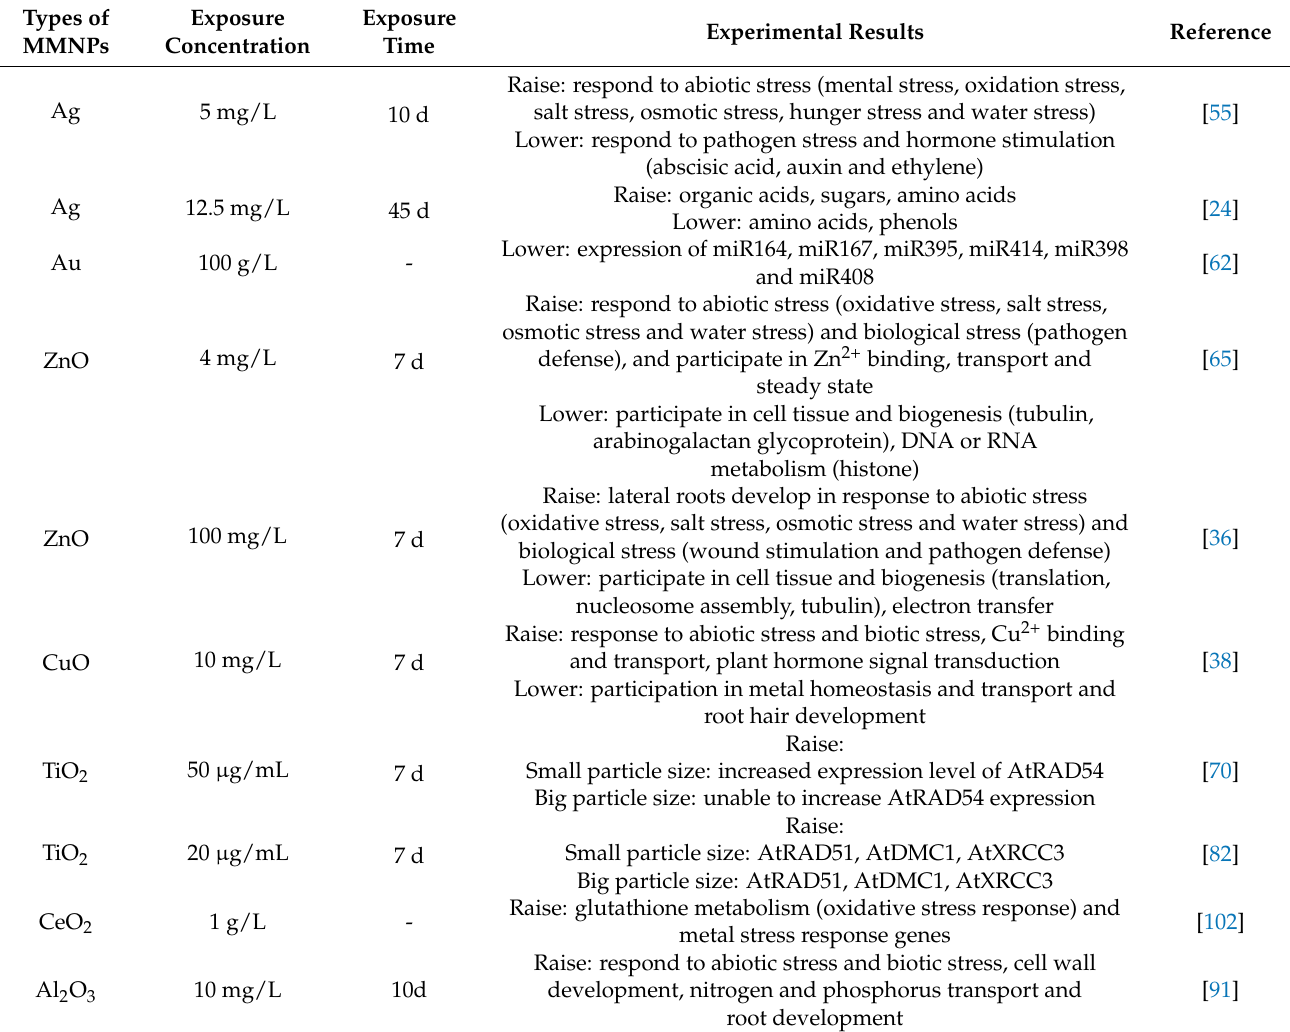
Table 2. Gene expression of Arabidopsis thaliana exposed to different MNP